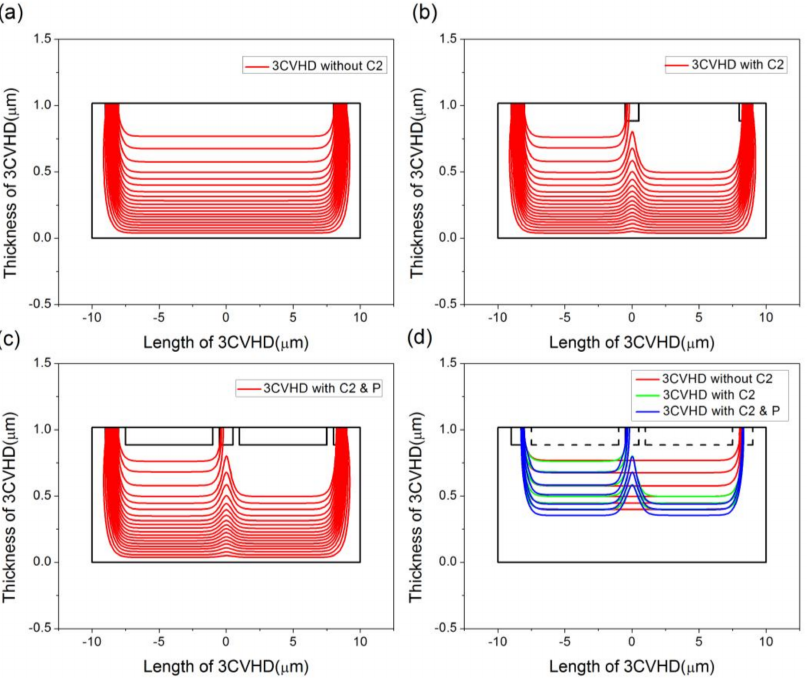
Figure 7. Effects of sensing contact and P-type layers on distribution of current density. ( a ) Sensor without C2. ( b ) Sensor with C2. ( c ) Sensor with C2 and P-type layers and ( d ) comparisons between three structures. The device is 1.018 µ m deep and P-type layers are 0.133 µ m deep.